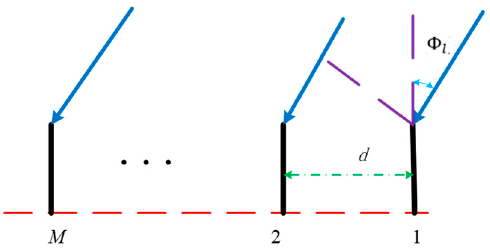
Figure 2. Receiving array ( d is the array spacing, φ l is the AOA of path l and M is the M th array